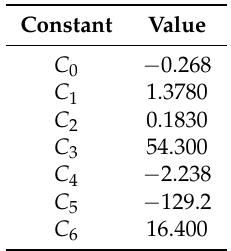
Table 2. Split-window